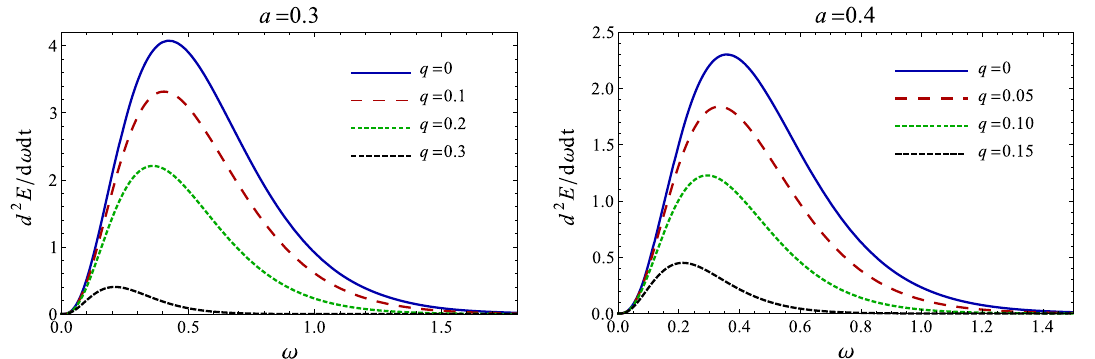
Fig. 9 Plotsshowingthevariationoftheenergyemissionratewithfrequency ω fordifferentvaluesofthecharge q andthespin a forfive-dimensional EMCS black holes with the case q = 0 referring to the Myers–Perry black